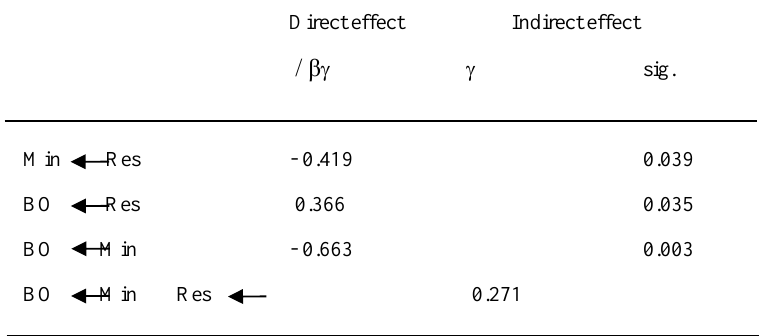
Table 2: Standardized Direct & Indirect effect